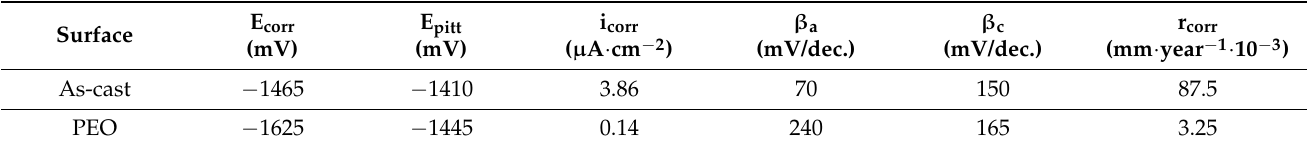
Figure 8. Potentiodynamic polarisation curves for as-cast and PEO surfaces in 0.1 M NaCl. Table 5. Electrochemical characteristics contained from Nyquist diagrams after 1 h of exposure in 0.1 M NaCl